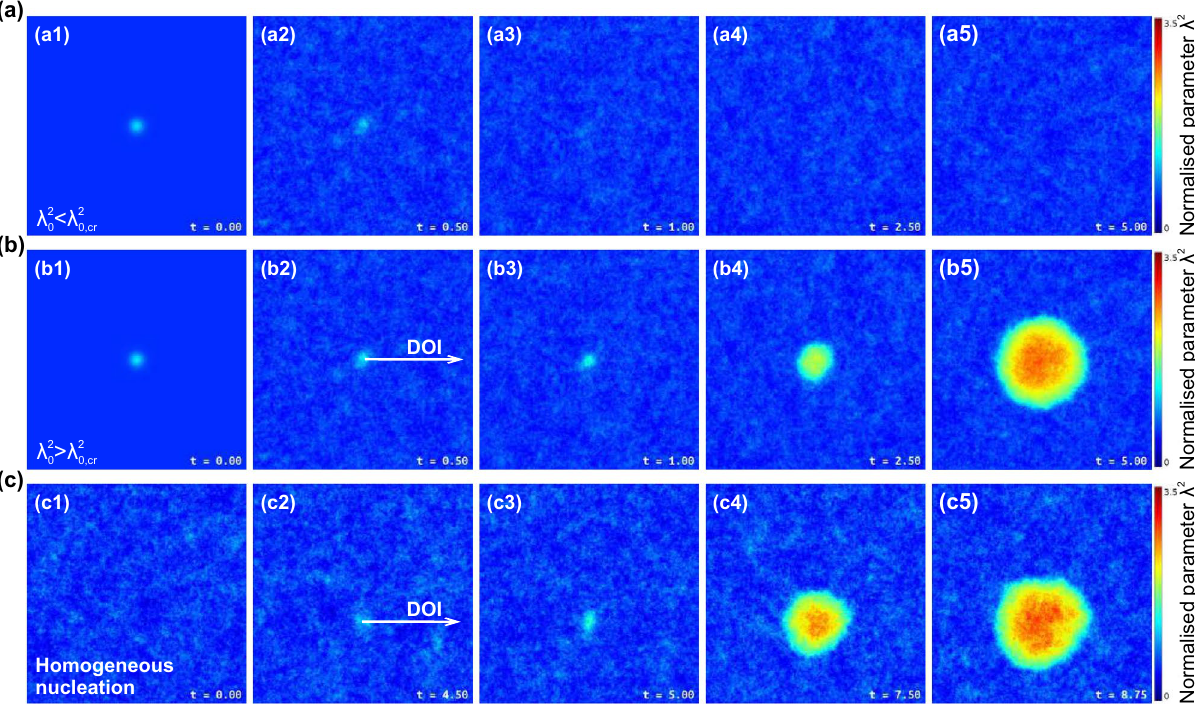
Figure 5. Evolution of different initial 2D (cylindrical) (cid:31) 2 -fluctuations (nuclei), and spontaneous nucleation in homogeneous system: Sequential frames illustrate the evolution of ( a ) subcritical and ( b ) supercritical (cid:31) 2 -fluctuation (nuclei), and ( c ) spontaneous nucleation due to thermal noise. For details see Supplemental Movies